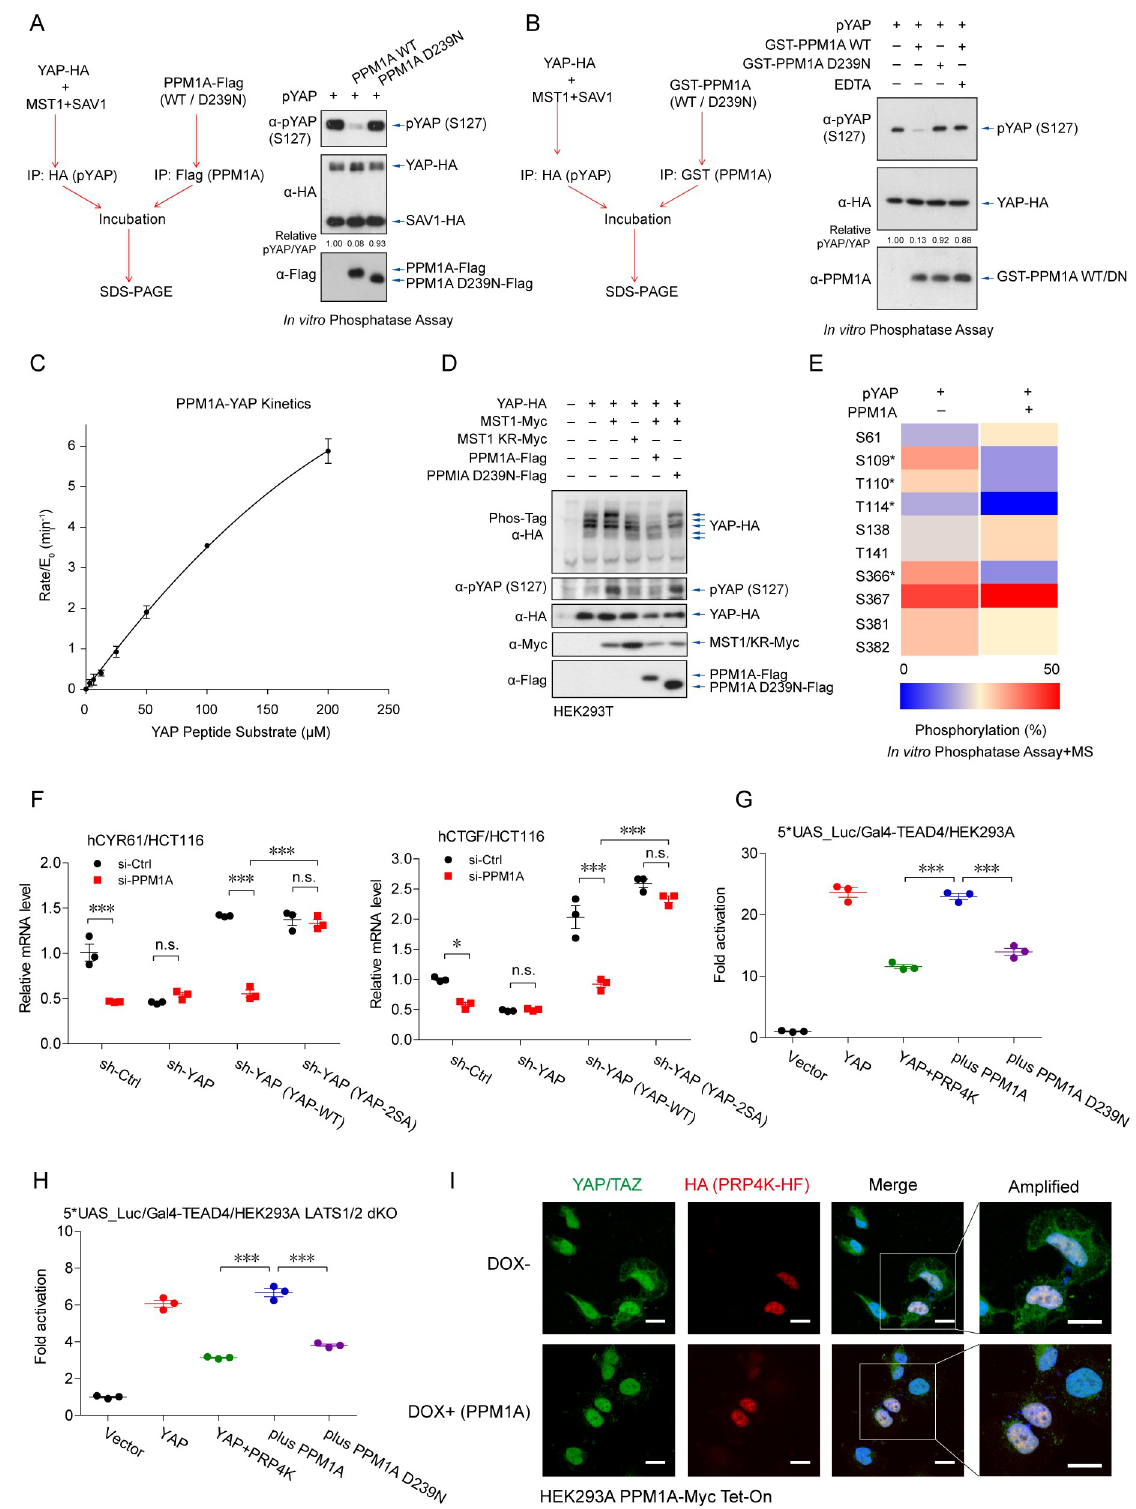
Fig 4. PPM1A directly and selectively eliminates YAP phosphorylation. (A, B) YAP was cotransfected together with MST1 and SAV1 and purified by the HA-tag to obtain the phospho-YAP proteins, which was incubated with separately purified PPM1A from cells (A)